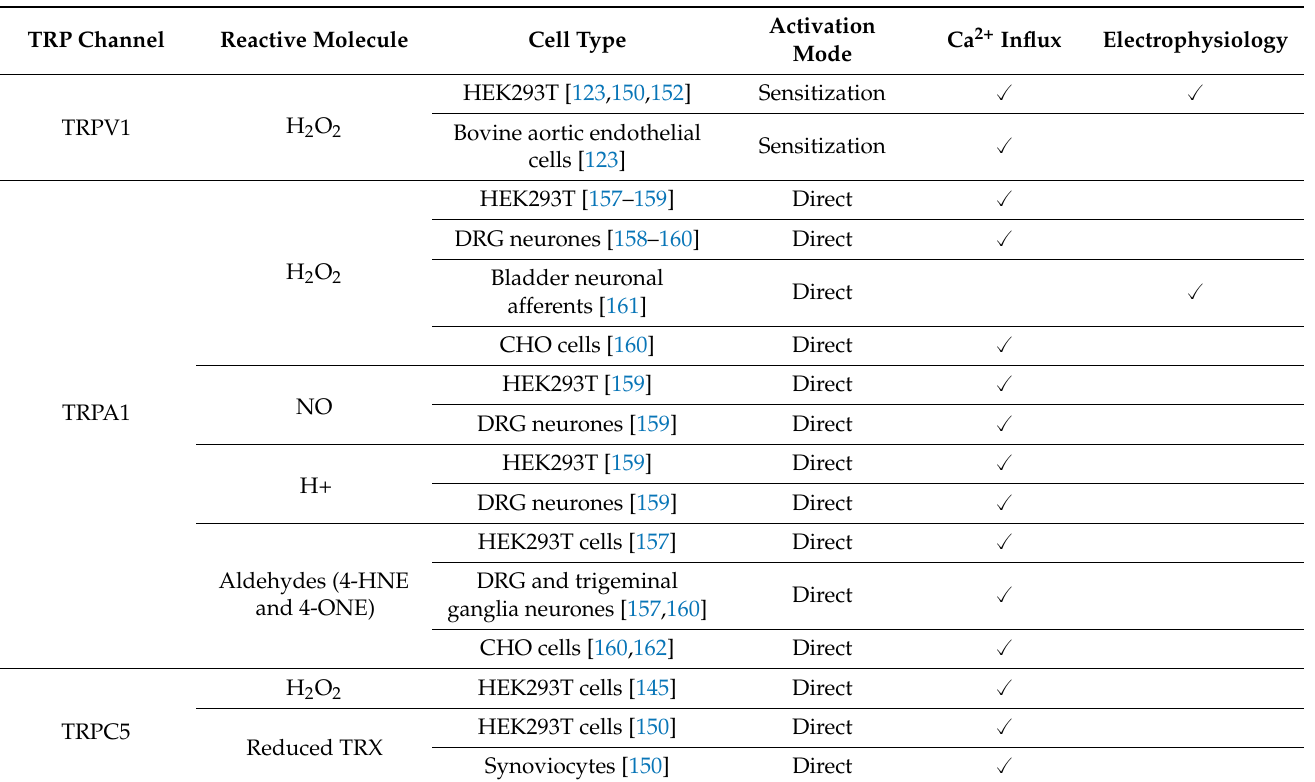
Table 1. Evidence for the functional activation of TRPV1, TRPA1 and TRPC5 by reactive molecules involved in metabolic